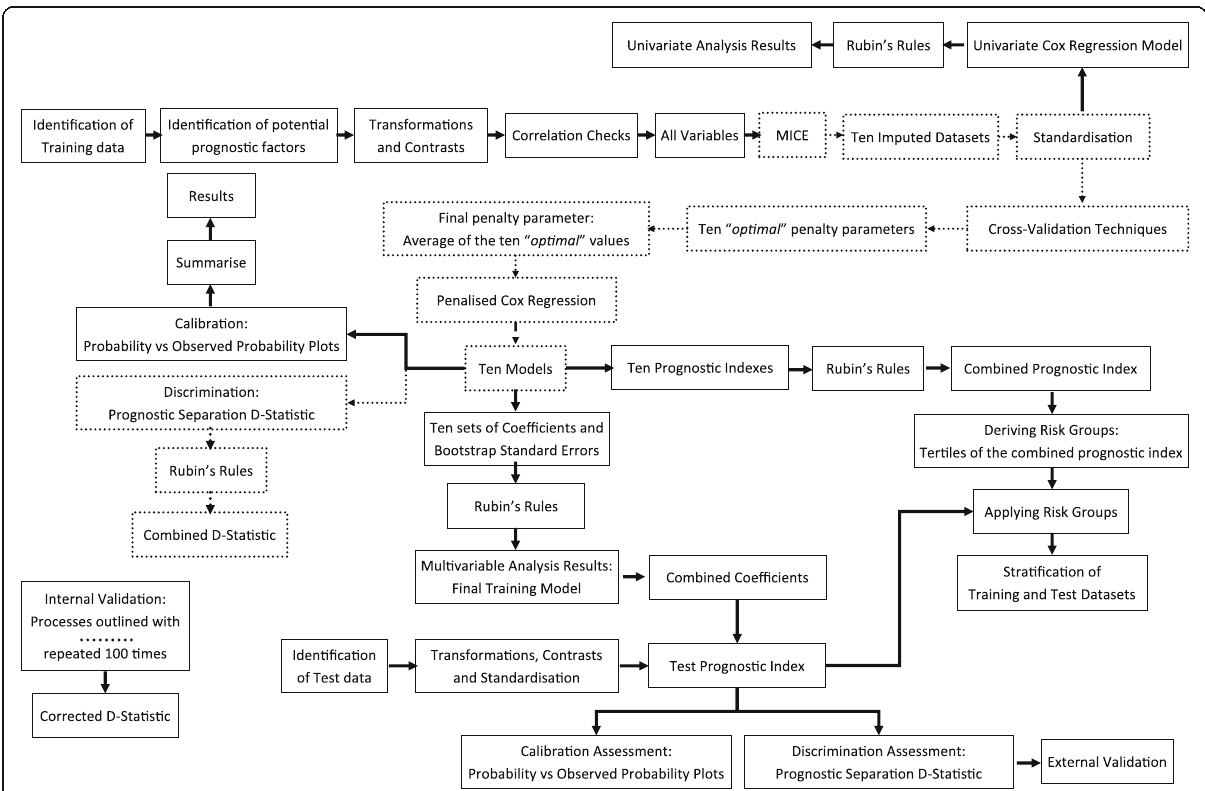
Fig. 4 An overview of the implemented methods. The dashed border represents the steps repeated from the model building process in the internal validation